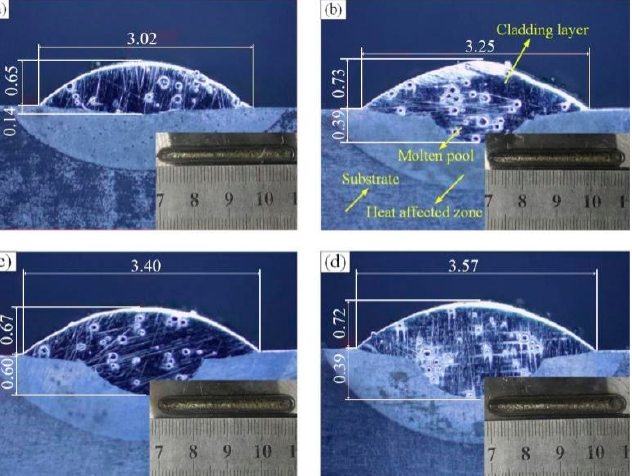
Figure 1. Macroscopic structure of a single-channel cladding coating with different laser powers: ( a ) 2.0 kW, ( b ) 2.4 kW, ( c ) 2.8 kW, and ( d ) 3.2 kW (measure unit is mm). ( a ) 2.0 kW, ( b ) 2.4 kW, ( c ) 2.8 kW, and ( d ) 3.2 kW (measure unit is